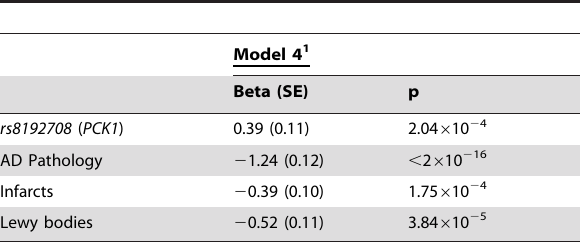
Table 8. PCK1 association with cognition is largely independent of AD pathology, infarcts, and Lewy